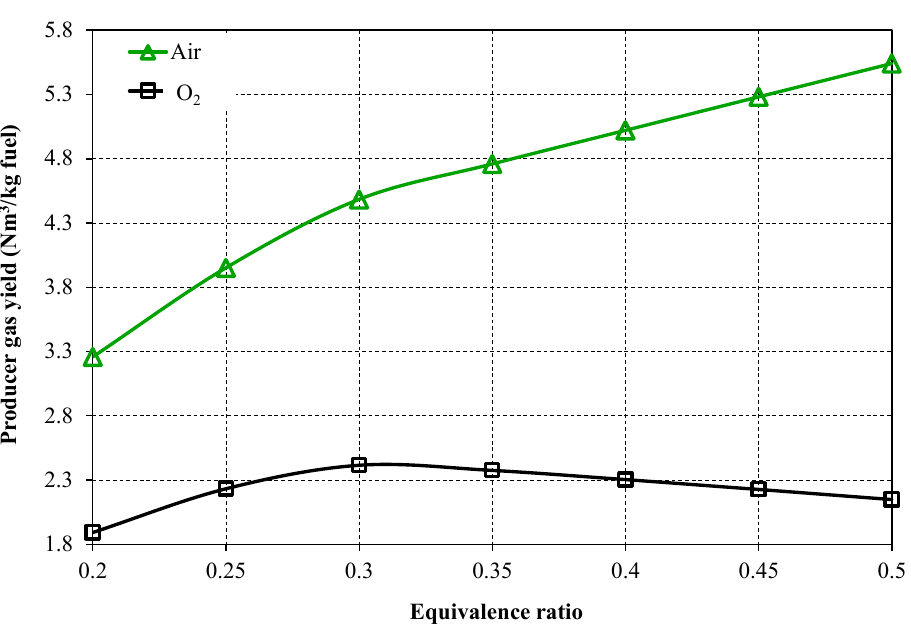
Figure 7. Producer gas yield.